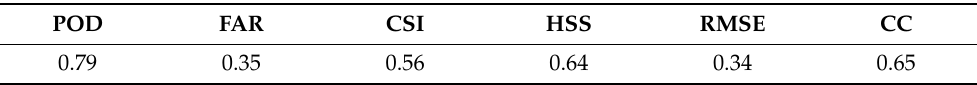
Figure 5. Comparison between IMERG precipitation data and PrecipGradeNet output during validation period. ( a ) precipitation of IMERG. ( b ) precipitation output by PrecipGradeNet. Table 7. Indexes between PrecipGradeNet estimation and IMERG in validation results of model training during 3 July 2021 to 11 July 2021, total 1,534,798 pixels.